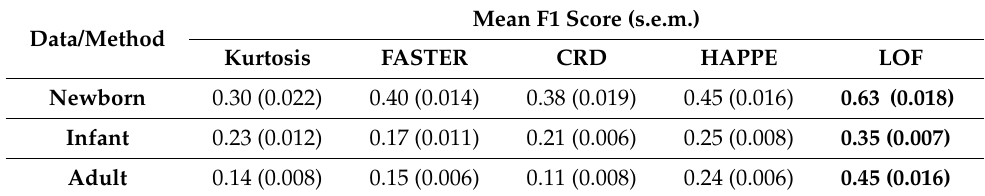
Table 2. Summary of results on real EEG.